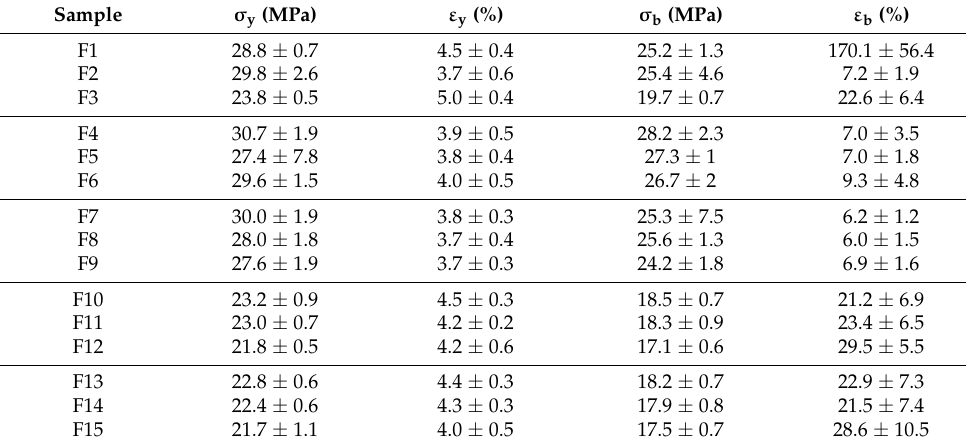
Table 5. Mechanical properties for PLA-based